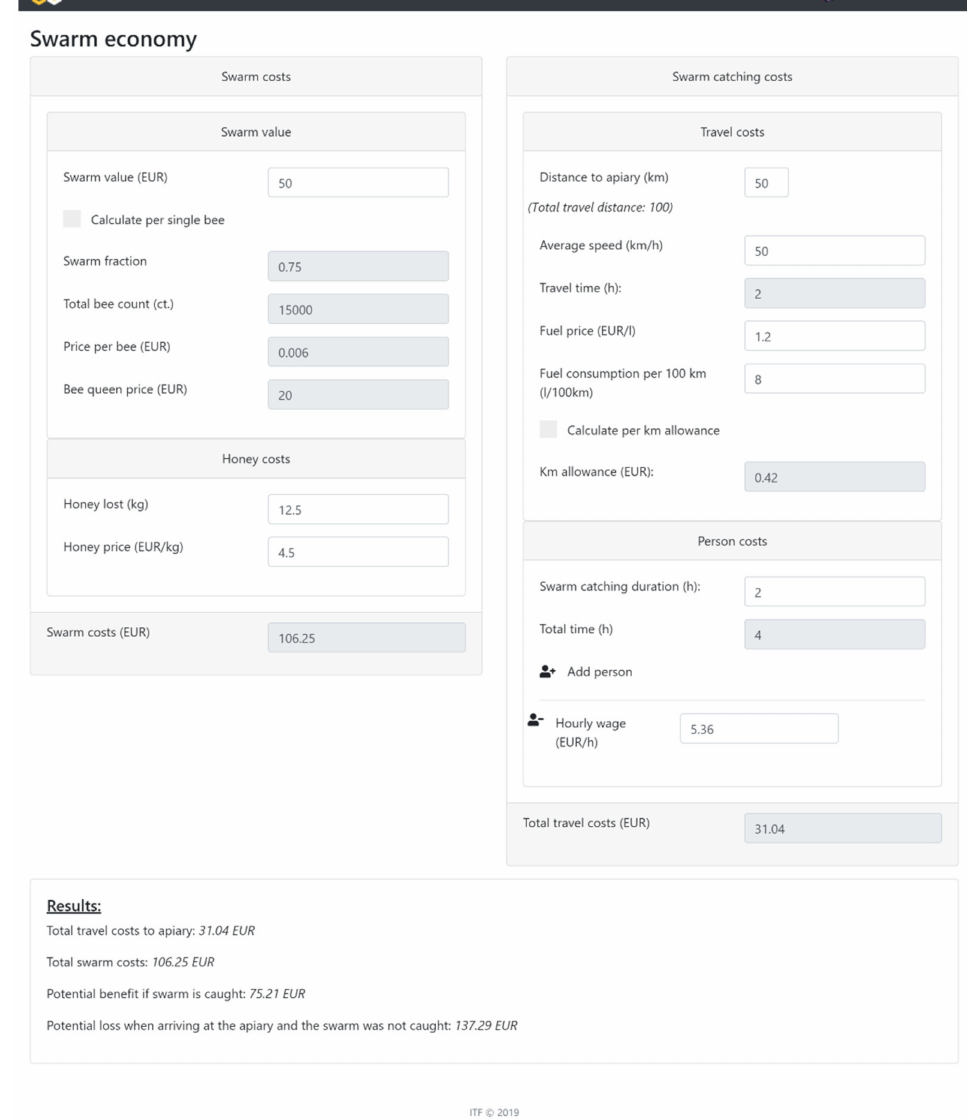
Figure 5. Screenshot of the developed web tool for running the